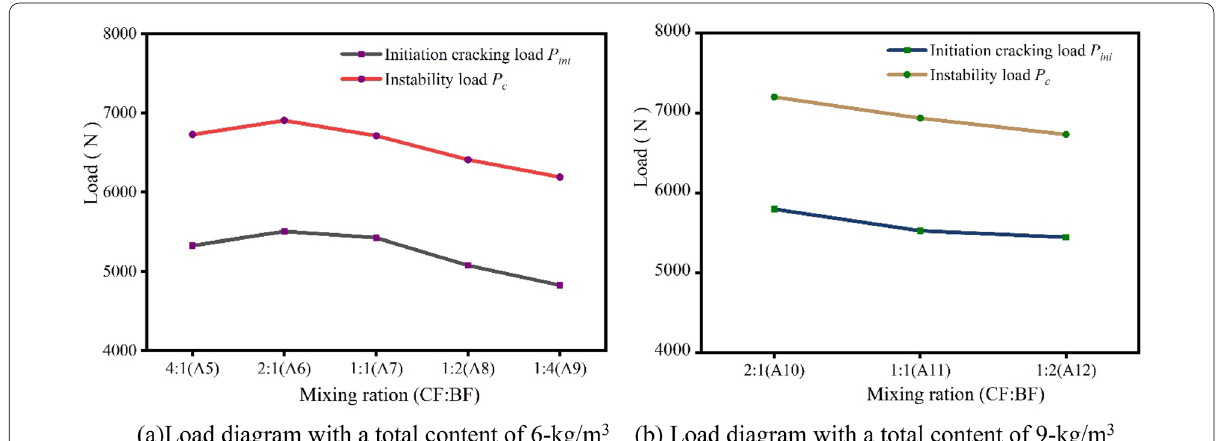
Fig. 10 Relationship between load and mixing ratio.